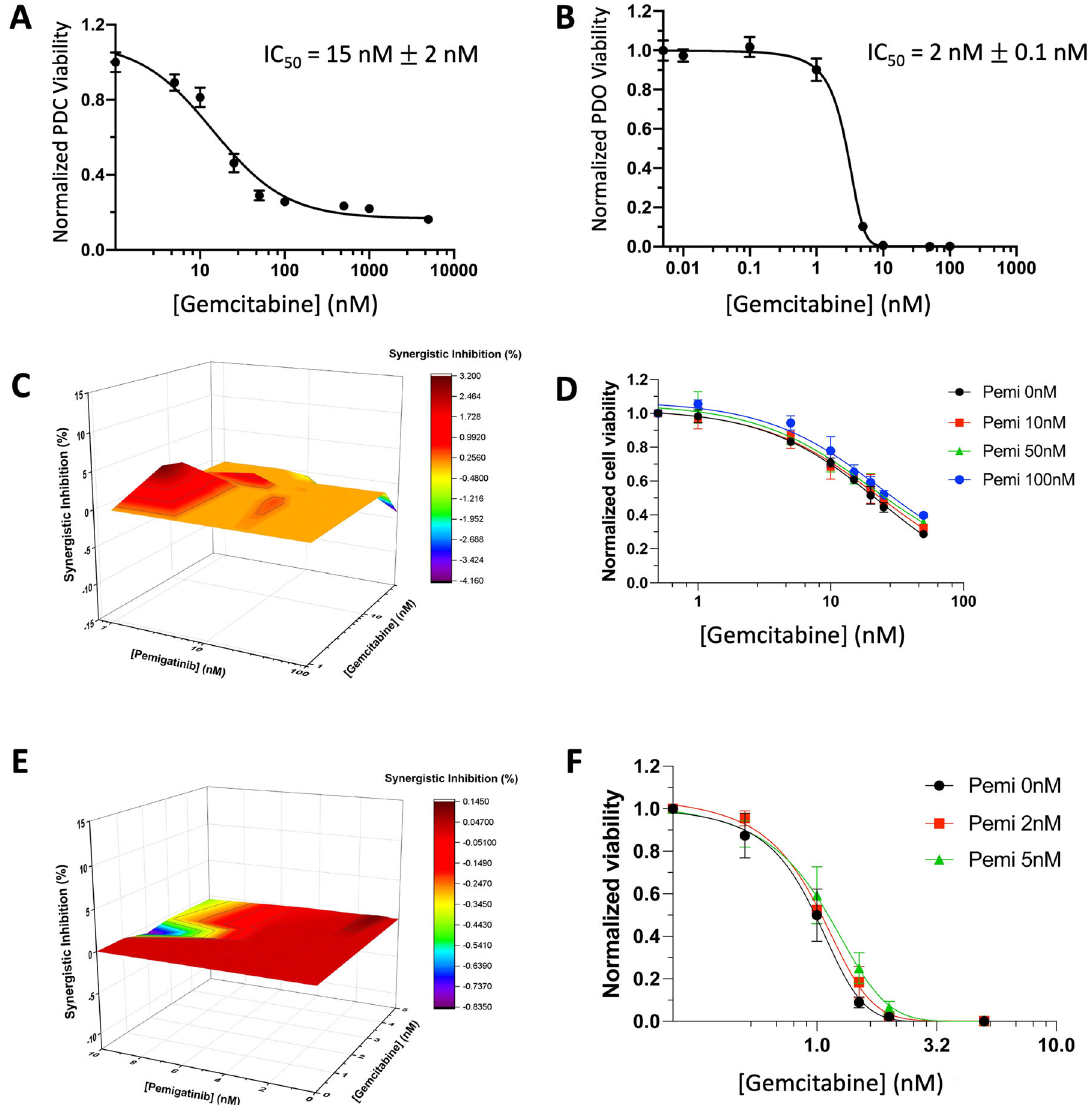
Fig. 5 Patient-derived FGFR2 fusion-positive ICC cell line and organoid models are sensitive to gemcitabine, with additive impairment in viability when combined with FGFR inhibition. A GI 50 assay with gemcitabine in the PDC model con fi rmed the IC 50 value to be 15 nM. B GI 50 assay with gemcitabine in the PDO model con fi rmed the IC 50 value to be 2 nM. C Gemcitabine and pemigatinib have additive effects on viability in the PDC model based on MacSynergy II calculation (95% con fi dence interval). Results are color-coded for range of synergy from purple (least synergistic) to dark red (most synergistic). Data below the 0 plane are antagonistic, in the plane are additive, and above the plane are synergistic. D Dose – response curves con fi rm additive effects of gemcitabine in the PDC model when combined with different concentrations of pemigatinib. All curves are normalized to 0 nM gemcitabine under the corresponding concentrations of pemigatinib. E Gemcitabine and pemigatinib have additive effects on viability in the PDO model based on MacSynergy II calculation (95% con fi dence interval). Data are represented as in C . F Dose – response curves con fi rm additive effects of gemcitabine in the PDO model when combined with different concentrations of pemigatinib (normalized as per D ). Viability results are normalized to DMSO control and presented as the mean + / − standard deviation (error bars) for three biologically independent